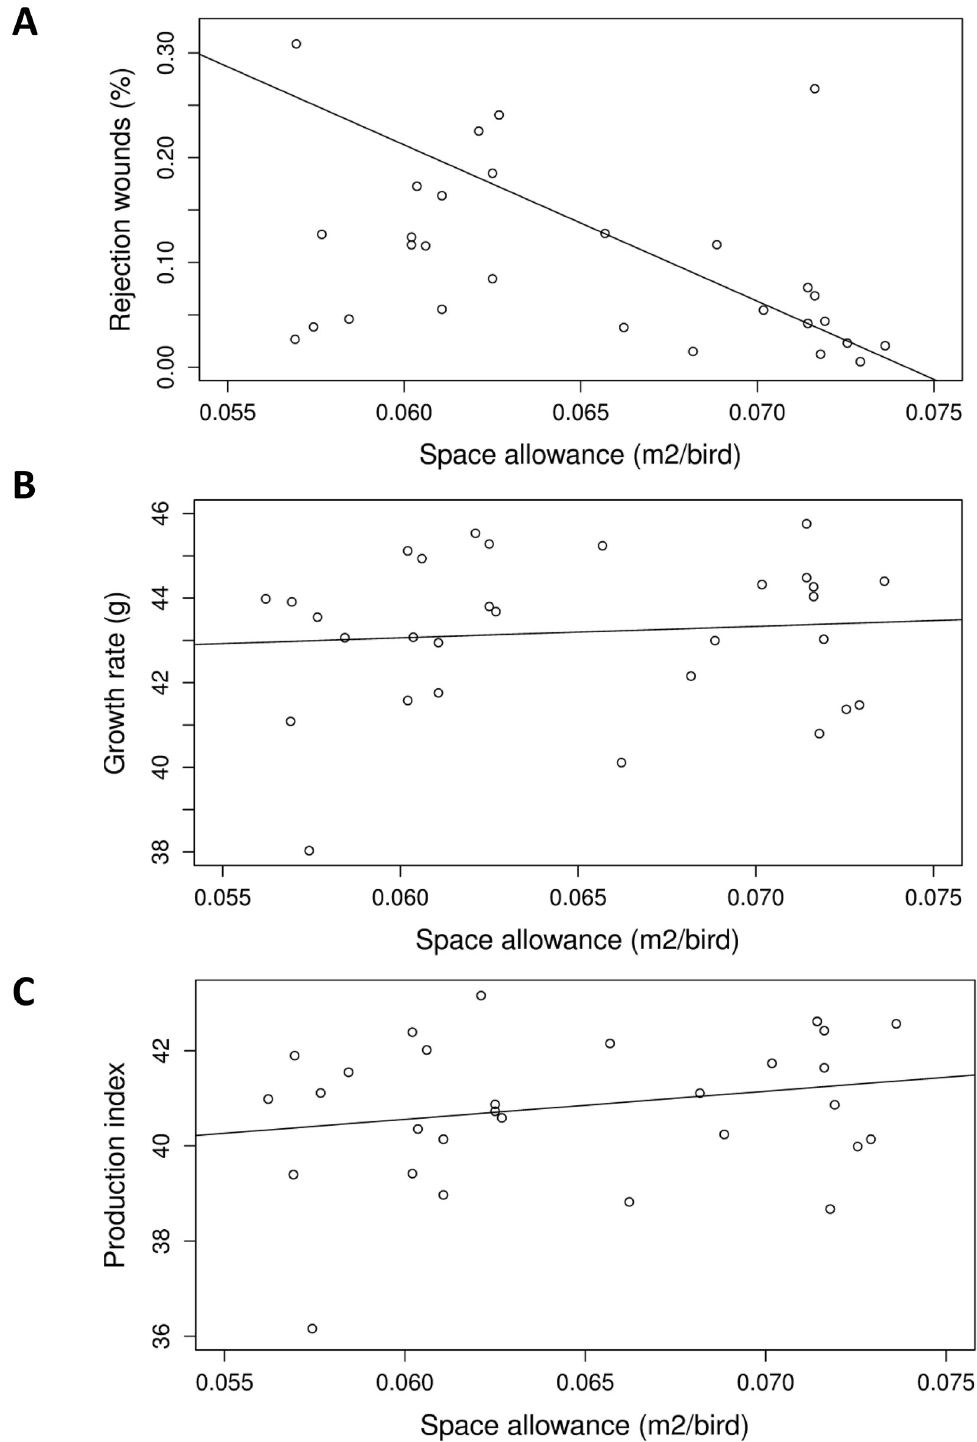
Fig 4. Associations of space allowance (m 2 /bird) with (A) rejections due to wounds (r 2 = 0.151), (B) growth rate (r 2 = 0.007), and (C) production index (r 2 = 0.048). Data points are back-transformed estimates from analysis of residuals of space allowance regressed on environmental complexity. (A) Carcasses rejected due to wounds as a % of total slaughtered birds. (B) [Mean g eviscerated carcass weight/days of age at slaughter]. (C) [Mean g eviscerated carcass weight � (number slaughtered − number rejected)/(days of age at slaughter � number of chicks